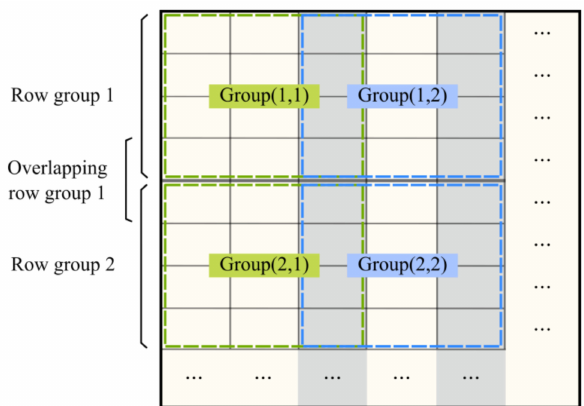
Figure 3. Example of grid-based group method for 2D raster data. The group method for every row group is similar to the column-based group method. One replica set of files in every normal group and overlapping row group is assigned to a